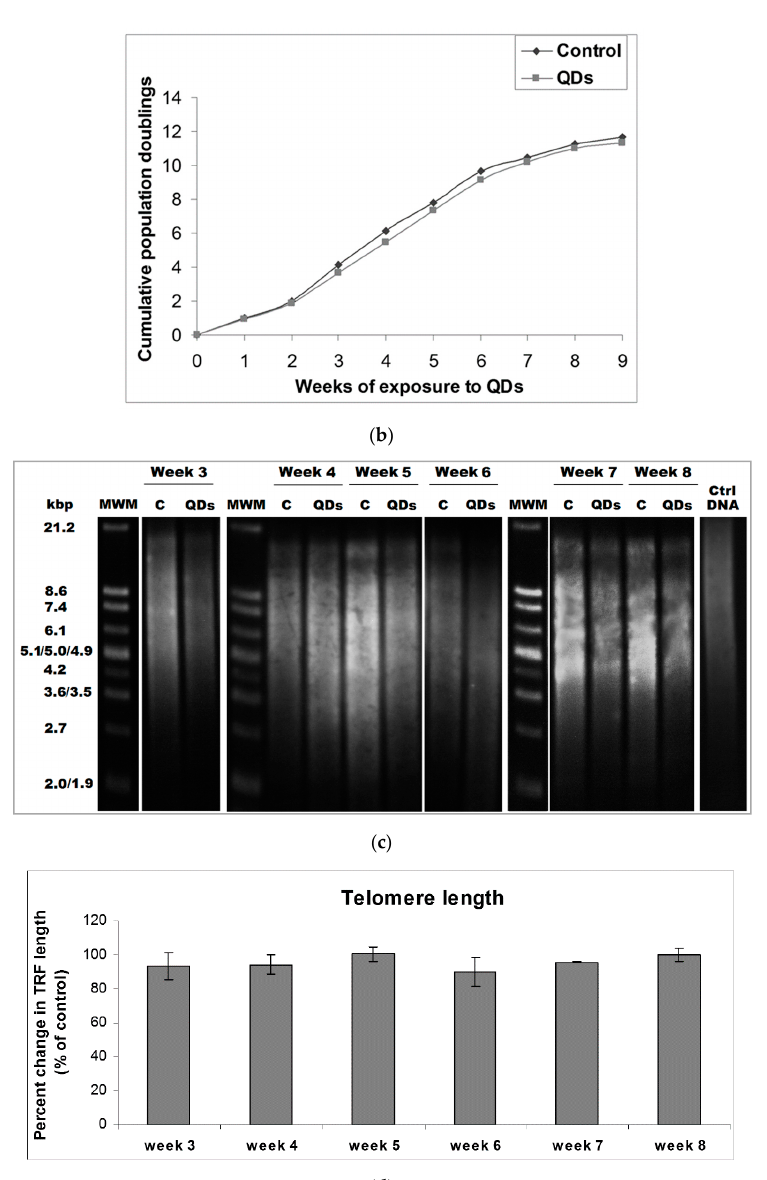
Figure 3. Influence triggered by Si/SiO 2 QDs on the cell growth of MRC-5 human lung fibroblasts during the 9-week exposure. Cell viability ( a ) and number of cumulative population doublings ( b ) were determined using Trypan blue staining during the 9-week incubation of MRC-5 cells with Si/SiO 2 QDs. Length of telomeric restriction fragments (TRFs) visualized by chemiluminescence detection ( c ) within the Southern blot technique was quantified ( d ) based on the migration distance of telomeric DNA in comparison to a known molecular weight DNA marker (MWM). The control DNA supplied by the manufacturer was represented by purified genomic DNA from immortal cell lines and confirmed that all steps of this method worked well. Results are calculated as mean ± standard deviation (SD; n = 3) and expressed relative to control (* p < 0.05 versus